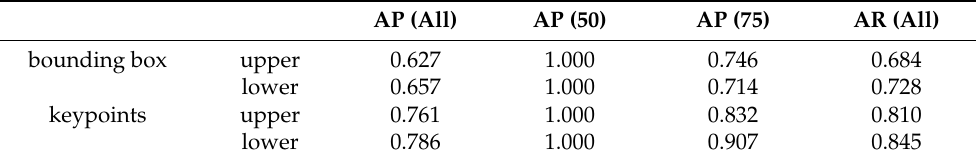
Table 1. Average precision (AP) and average recall (AR) on various intersections over union (IoU) and object keypoint similarity (OKS) thresholds.